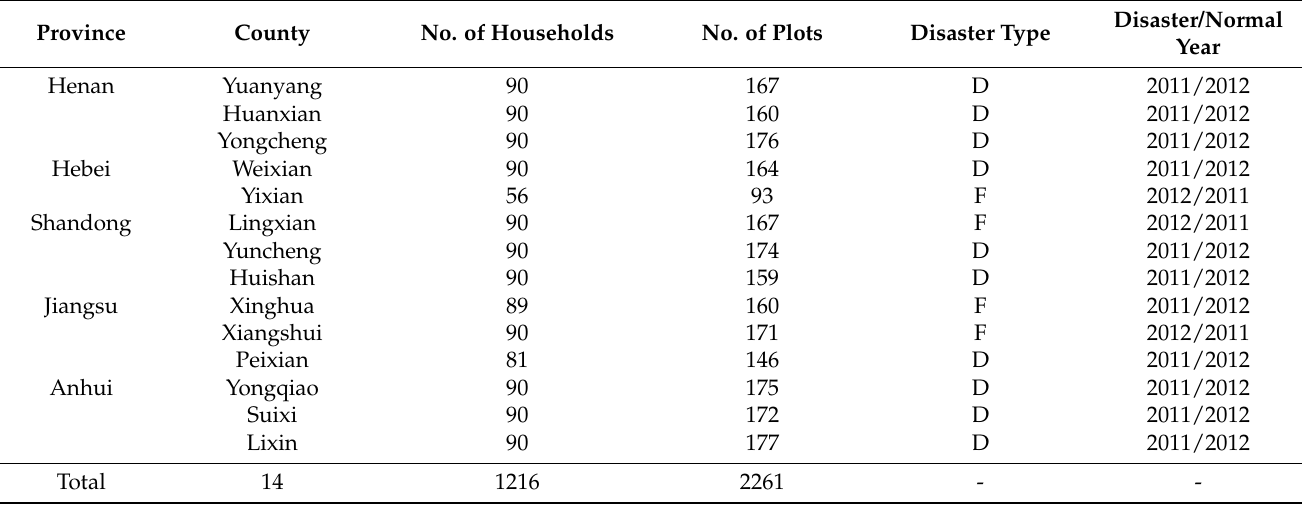
Table 1. The sample distribution of winter wheat for the